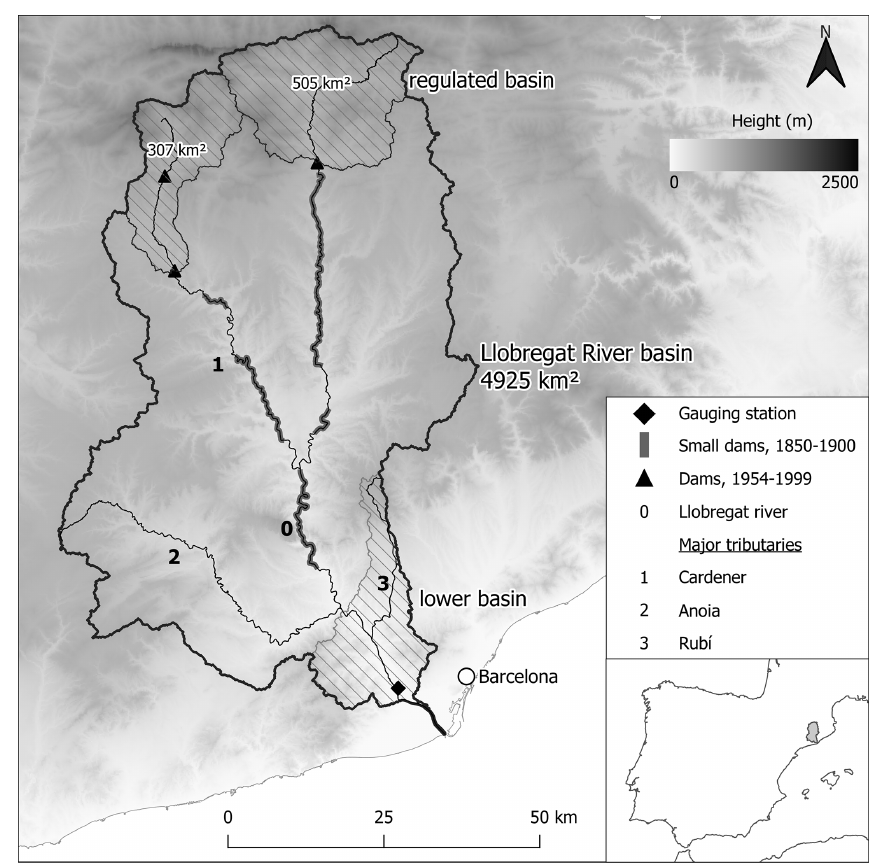
Figure 1. Location map. For the lower basin see the zoom in Fig. 4. For small dams see the discussion